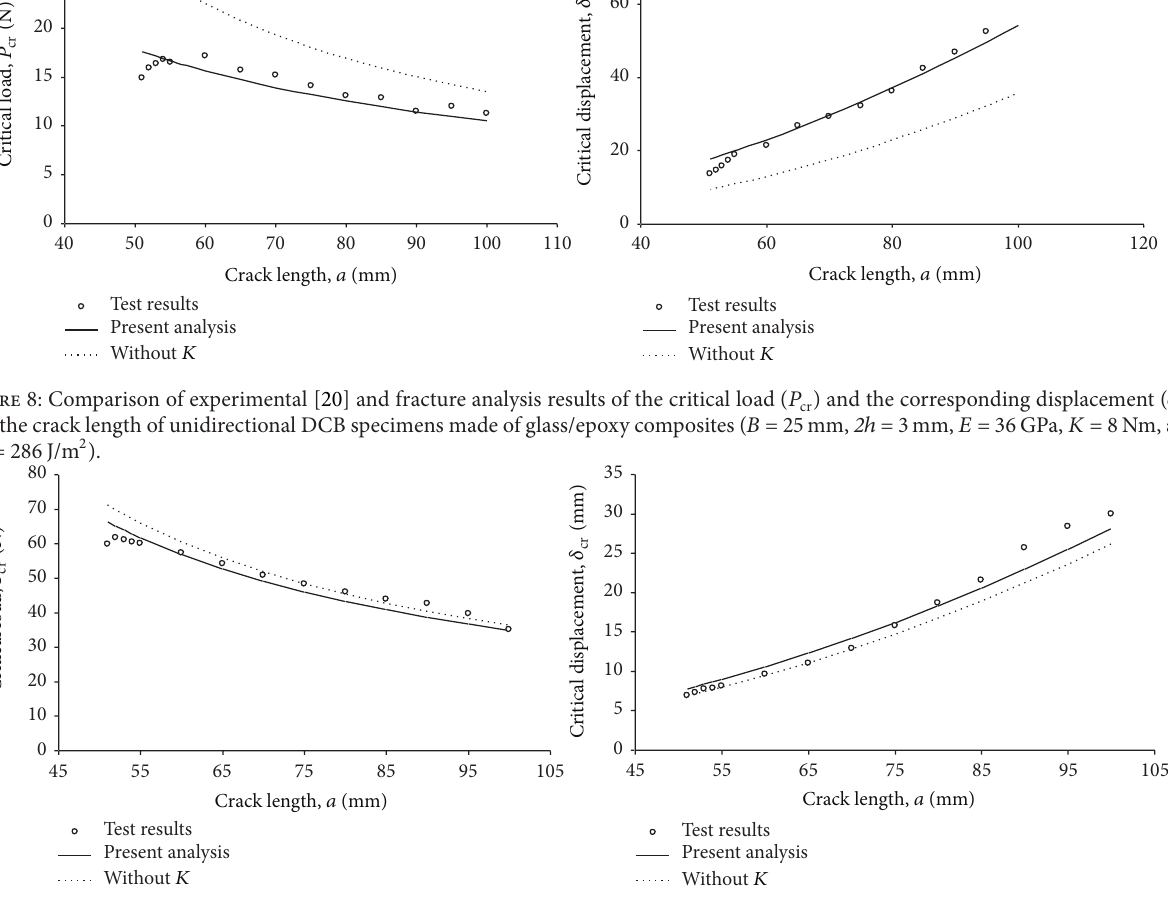
) and the corresponding displacement (𝛿 ) cr cr